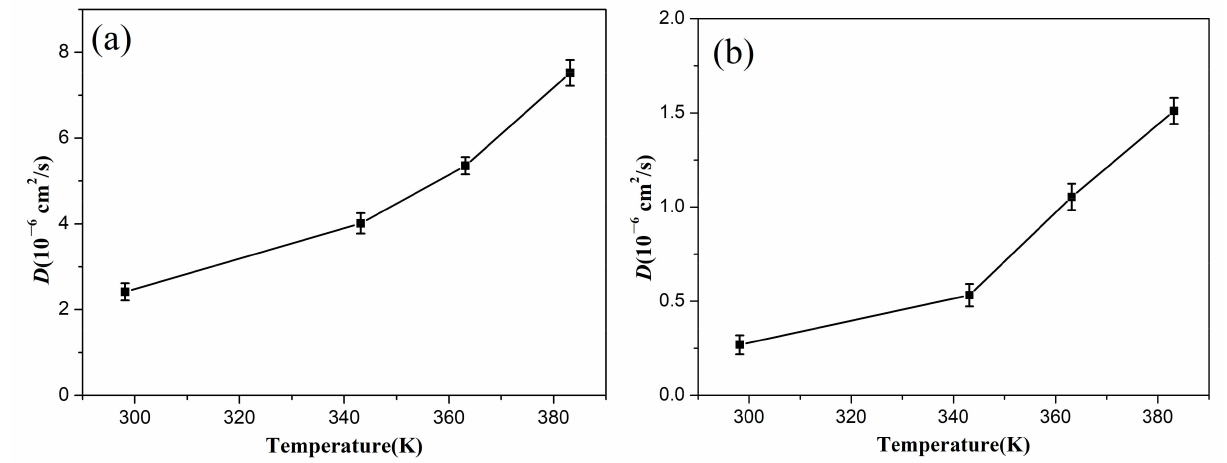
Figure 11. The diffusion coefficients of the cyclohexane molecules in the uncompressed ( a ) and compressed ( b ) rubber at different temperatures.